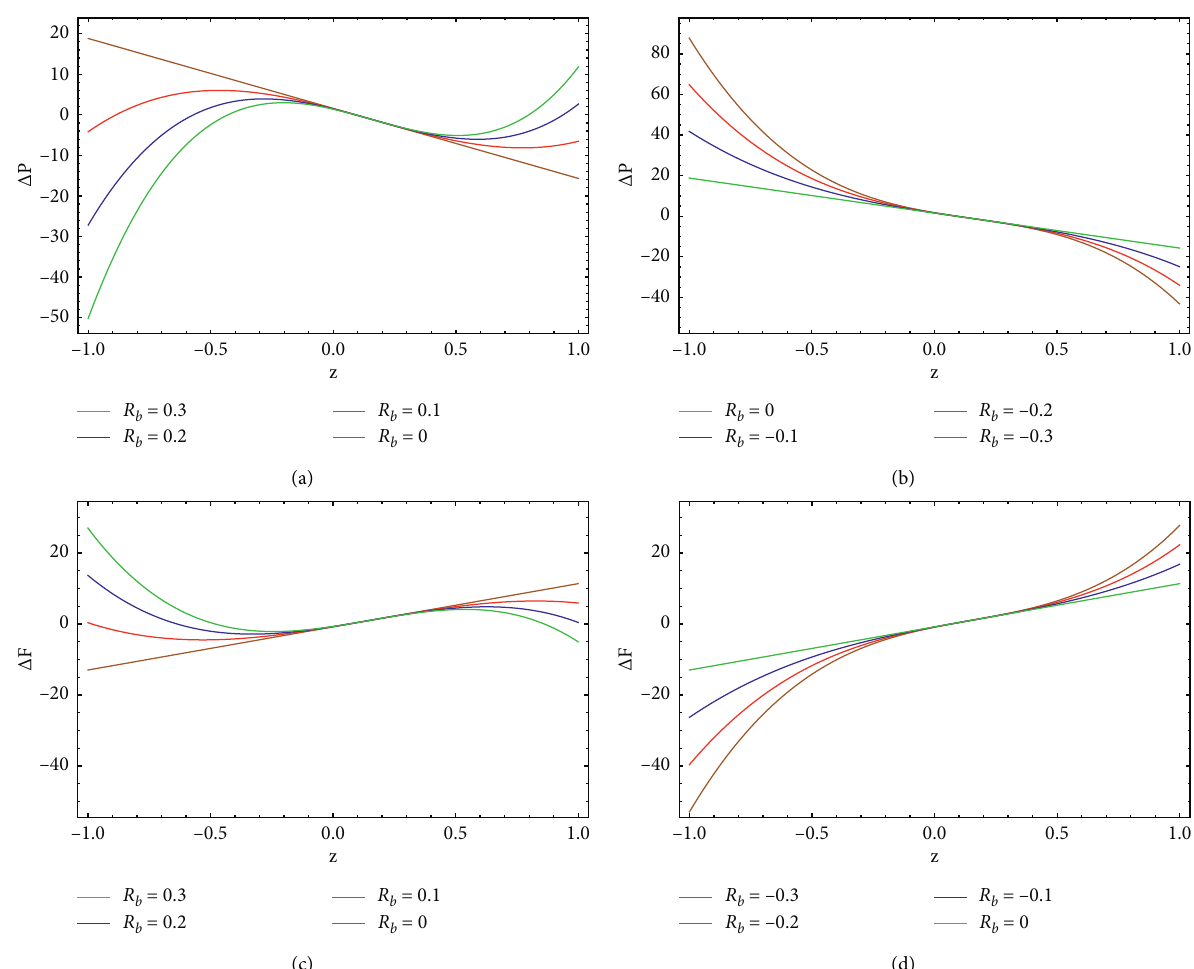
Figure 7: The variation of pressure rise Δ P and friction force Δ F versus mean flow rate for different values of R